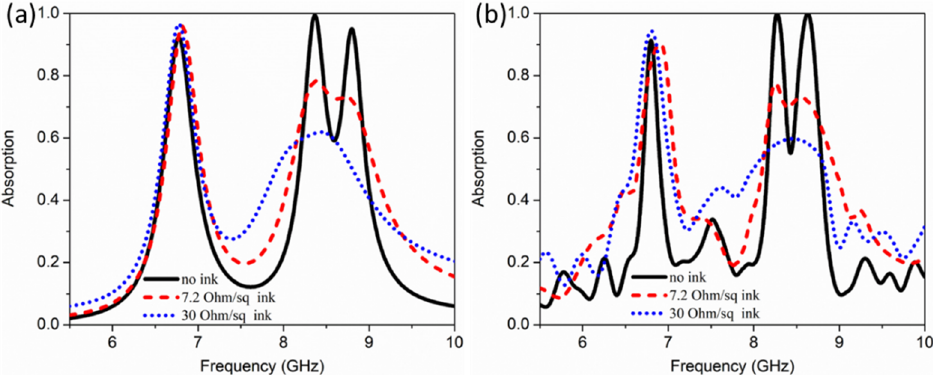
Figure 6. ( a ) Simulated and ( b ) experimental absorption spectra of bare and graphene-integrated plasmonic MAs with different resistances of graphene ink.